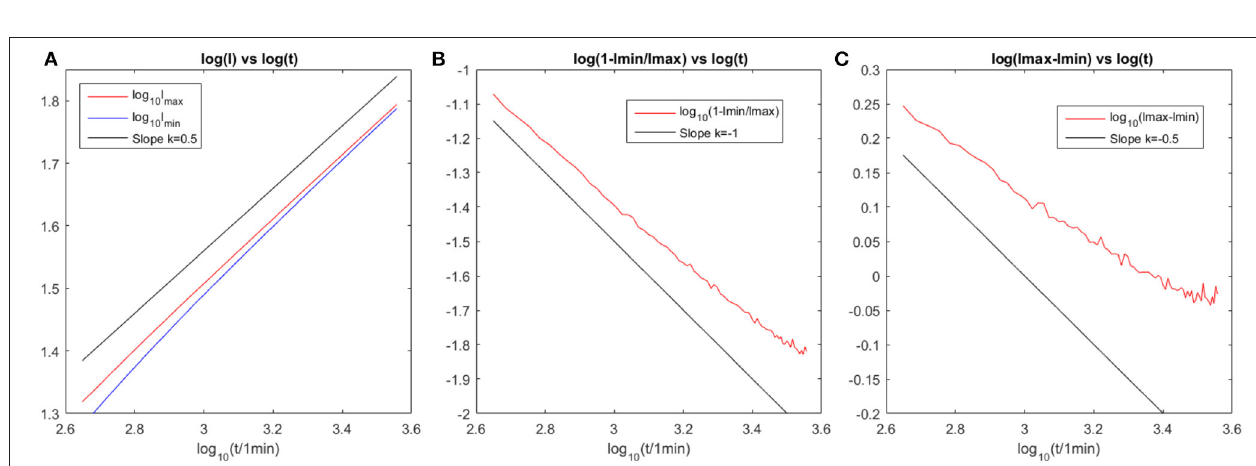
FIGURE 12 | Evolution of characteristic length scales in the system with time. The corresponding log-log plot for Figure 11 is shown. (A) Logarithmic plot of the maximum and minimum convection length evolution with time, where the black line gives a reference slope of k power law of √ t . (B) One minus the ratio of the two lengths evolution with time follows the power law of 1 / t with a reference slope k two lengths evolution with time follows the power law of 1 / √ t with a reference slope k